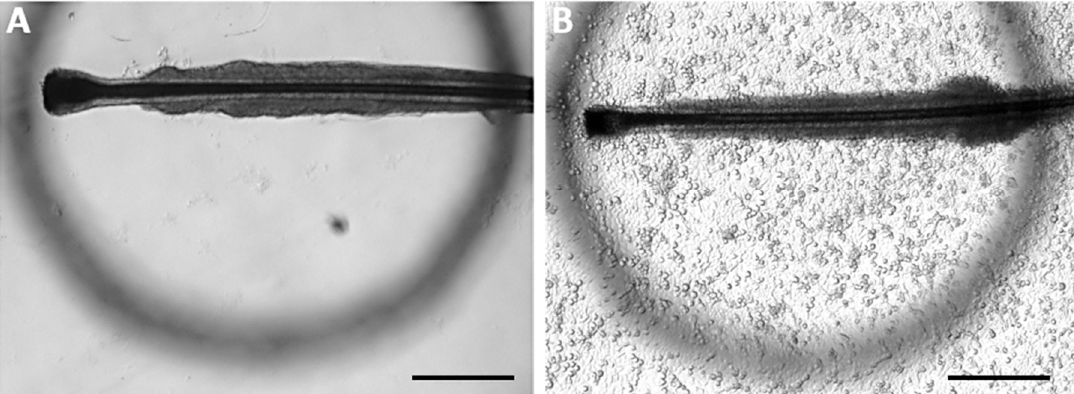
Figure 2. Light microscopy pictures of cultured HFs with the “circle condition”. A circle with a defined area of 0.3 mm in diameter is attached below the culture vessel. ( A ) Intact HF with the first outgrowing keratinocytes. Keratinocytes have not yet fulfilled the “circle condition”. ( B ) Keratinocyte cell layer reaching the size of the defined area of the circle and therefore categorized as achieved “circle condition”. This criterium is reached after an average of 6 to 8 days. Scale bar: 500 µm.